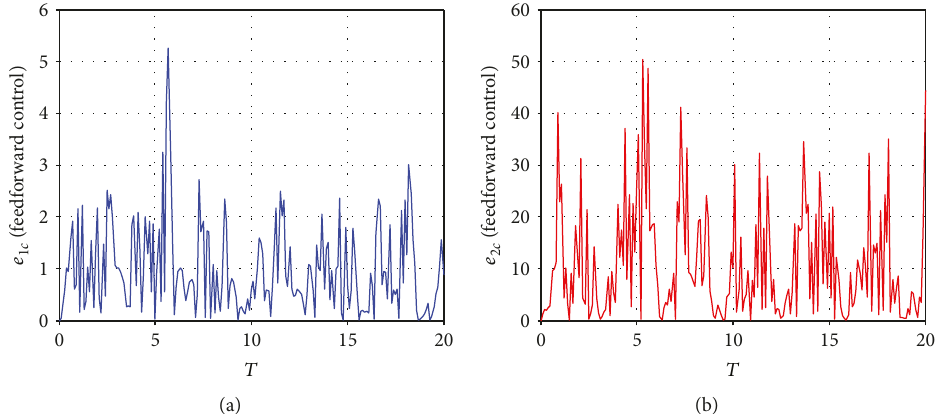
Figure 9: Deviation of the desired trajectory with the proposed control with parametric errors in feedforward control ( u ~ ): (a) deviation of the = u − u u desired trajectory e 1 1 c 1 c and (b) deviation of the desired trajectory e 2 c c